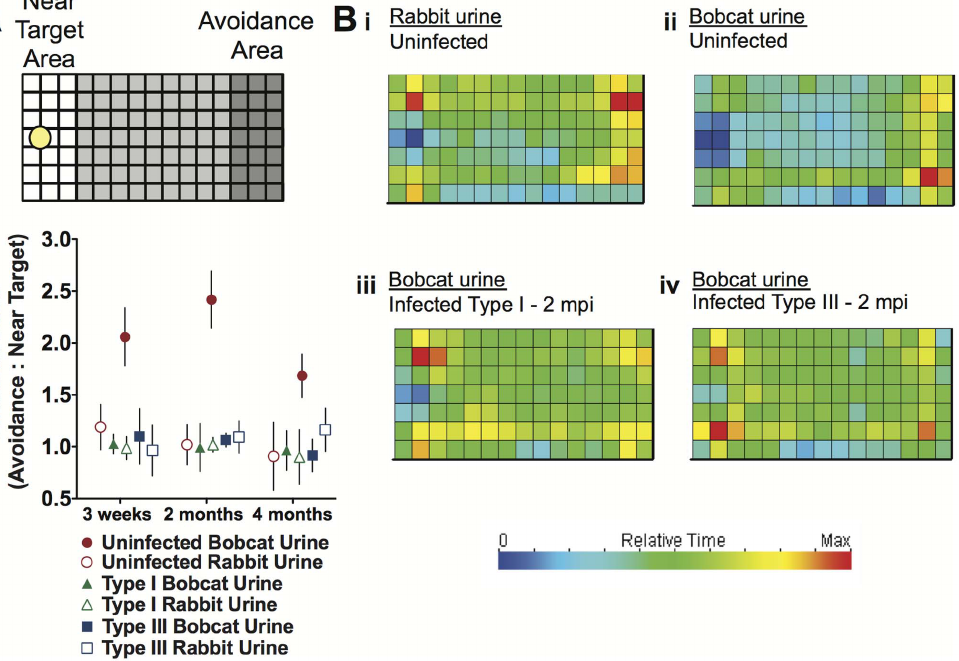
Figure 1. Assessment of aversion demonstrates loss of fear toward cat urine in Type I- and Type III-infected mice. [A] Overhead representation of behavioral arena where a small dish containing the ‘target’ solution (yellow disk) is affixed at one end of the behavioral arena. ‘Near Target’ is defined as the area of the arena (white) proximal to the target. ‘Avoidance’ is defined as the most distal region (dark grey) of the enclosure relative to the target. [B] Representative heat maps of mouse place preference during a 60-minute trial of (i) uninfected mice exposed to rabbit urine, and (ii) uninfected, (iii) attenuated Type I-infected, and (iv) low-virulence Type III-infected mice exposed to bobcat urine from trials conducted at 2 months post infection. [C] Aversion ratio, the avoidance time to near target time, of uninfected (red circles), Type I-infected (green triangles), and Type III-infected (blue squares) animals when exposed to bobcat urine (filled shapes) or rabbit urine (open shapes) at 3 weeks, 2 months, and 4 months post infection (n=10 for each group). Error bars are the Standard Error of the Mean